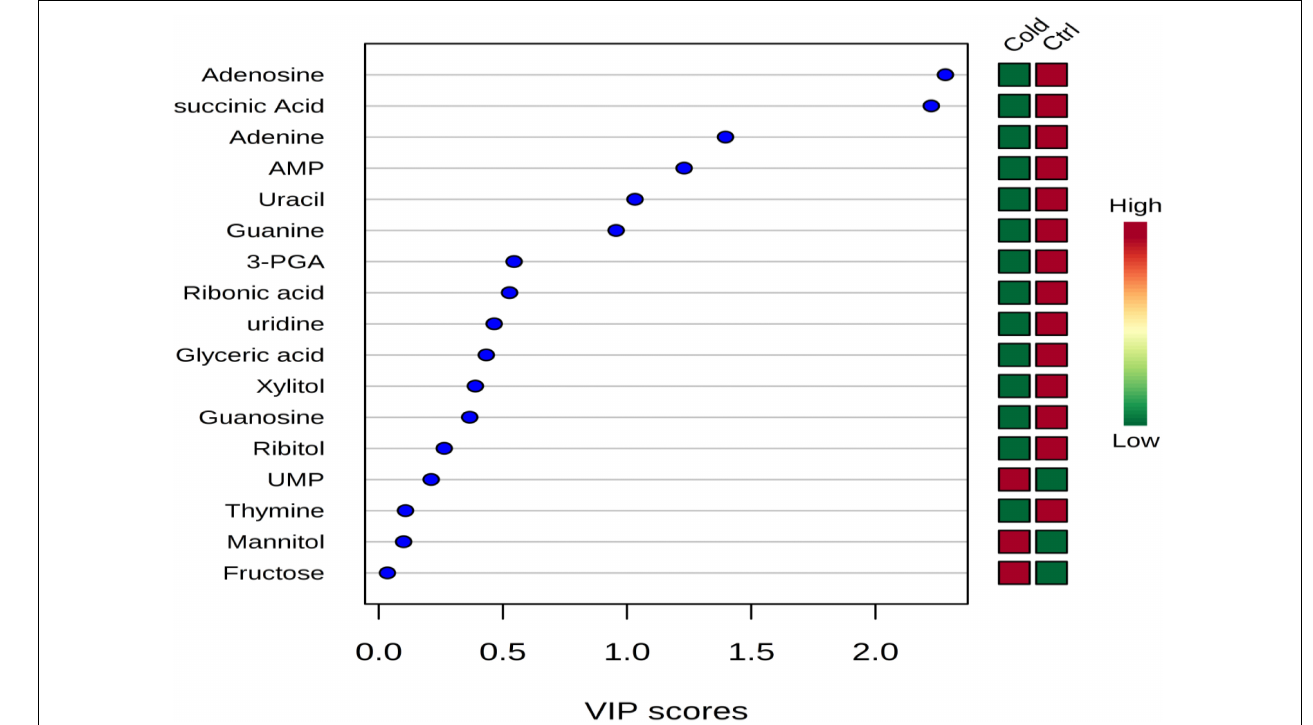
FIGURE 3 | Variable importance in projection (VIP) scores indicating the top important metabolites contributing to the separation of metabolic profiles in control replicates vs. cold stressed samples. The relative abundance of metabolites is indicated by a colored scale from green to red representing the low and high,